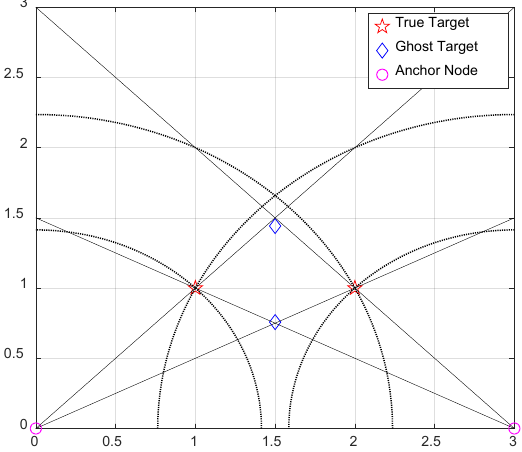
Figure 2. The relationship among true targets and ghost targets in a 2-D